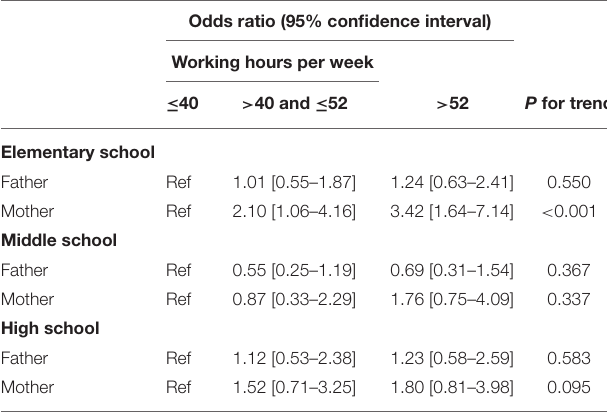
TABLE 4 | Logistic regression analysis for dyslipidemia (low-density lipoprotein cholesterol ≥ 130 mg/dl) in the participant children by working hours of the father or mother.